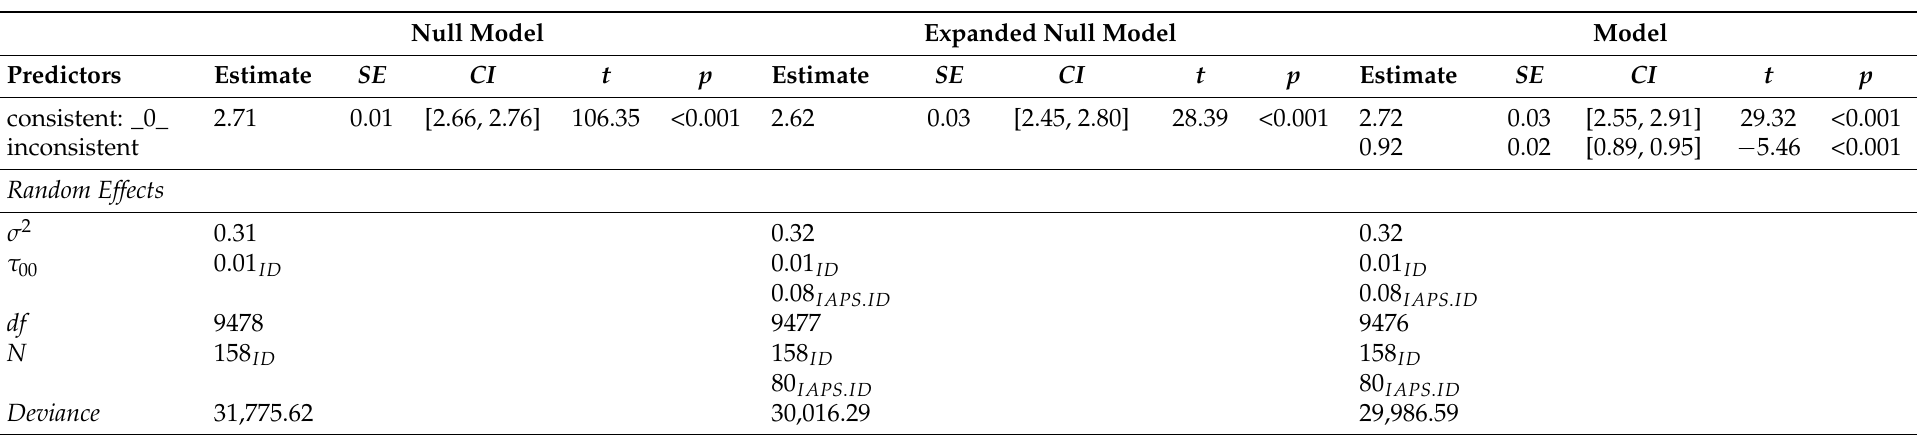
Table A2. Mixed model of the influence of binary stimuli conditions on the emoscale widget